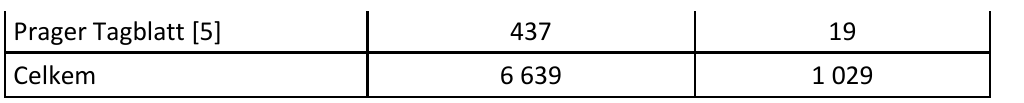
Tabulka 1: Použitá periodika a počet vytěžených inzertních záznamů pro Prahu a Středočeský kraj.